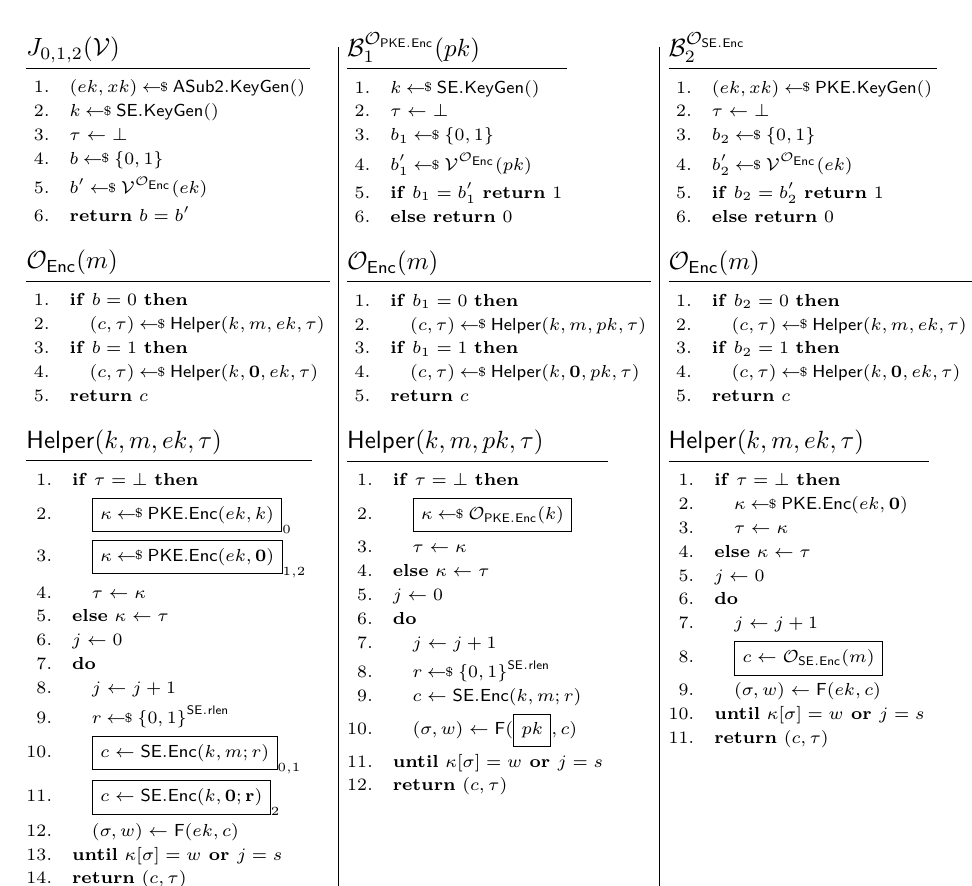
Figure 13: Games J 0 , J 1 , and J 2 and adversaries B 1 and B 2 for proof of Theorem 4. In the J -games, each game only include the boxed code if it has matching subscript. In B and B , the boxes serve to highlight 2